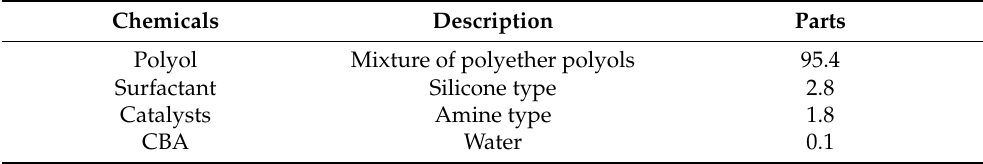
Table 1. Chemical composition of the formulated